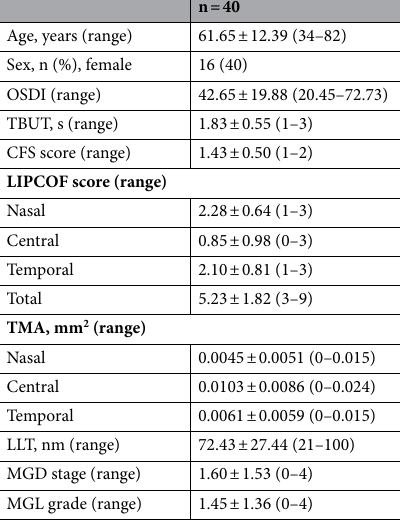
Table 1. Demographic characteristics of patients enrolled in the present study. All data are shown as the mean ± standard deviation. OSDI, ocular surface disease index; TBUT, Tear break-up time. CFS, corneal and conjunctival fluorescein staining based on Oxford schema; LIPCOF, Lid-parallel conjunctival folds; TMA, tear meniscus cross-sectional area; LLT, Lipid layer thickness; MGD, Meibomian gland dysfunction; MGL, Meibomian gland loss.